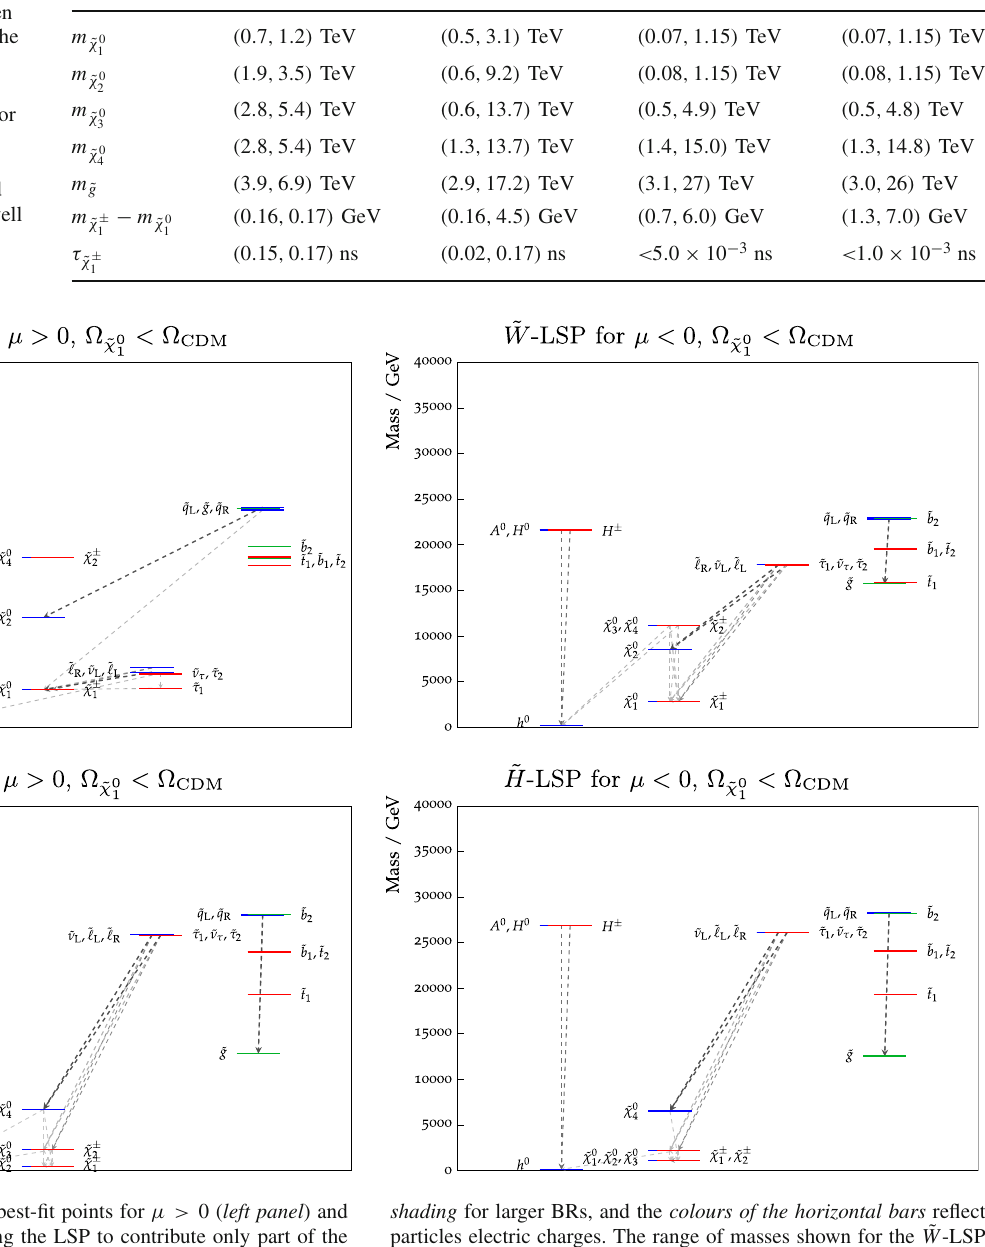
< (cid:4) Allowing (cid:4) ˜ χ 0 CDM , we found in our sample 1